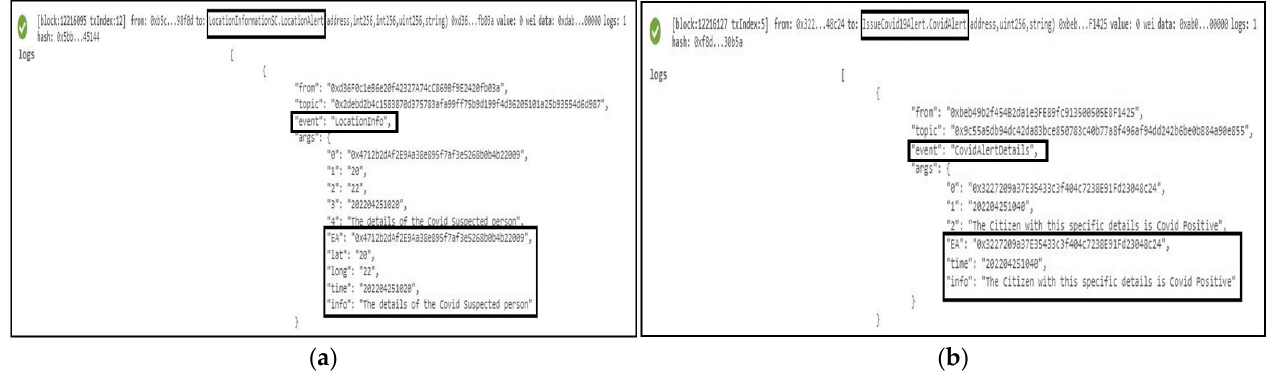
Figure 10. Logs representing deployment of the Contract Tracing smart contract. In ( a ), the location info of the user is depicted while in ( b ), the alert details of a COVID-19-positive patient’s info are accommodated.